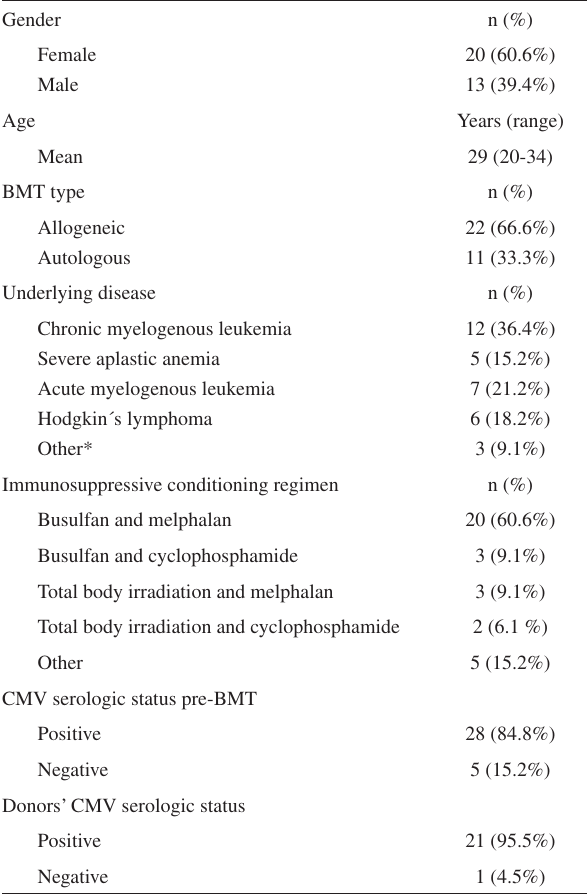
Table 1 - Patient demographics, BMT type, underlying dis- ease, and immunosuppressive regimens used before